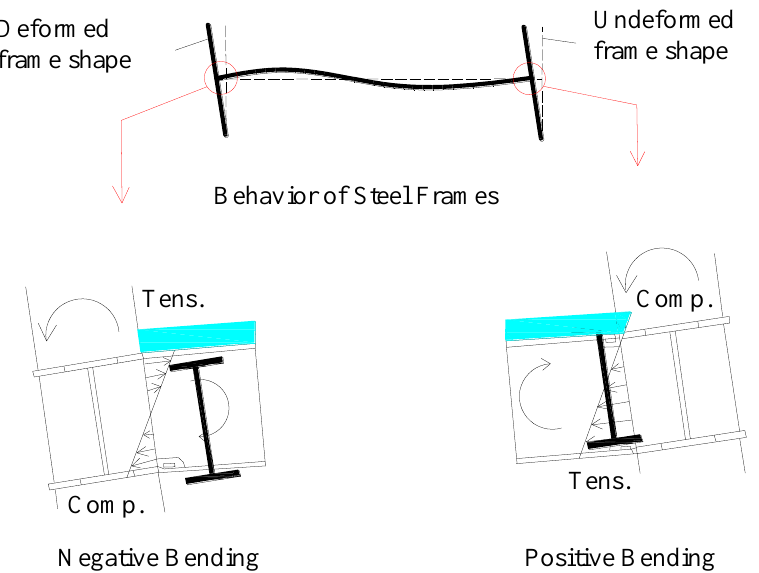
Figure 2. Strain distributions of composite beams.